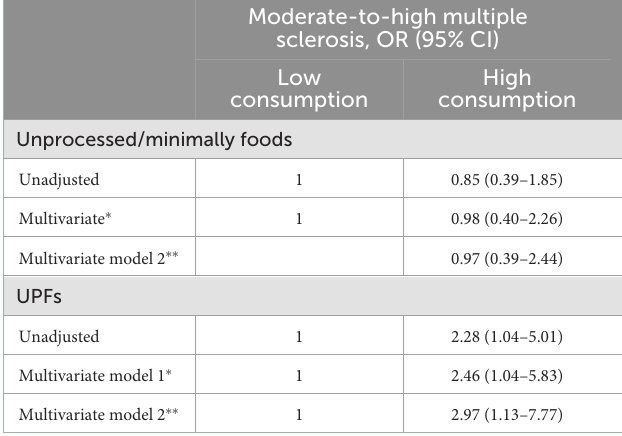
TABLE 5 Association between food intake based on level of processing and moderate-to-high multiple sclerosis (as compared to mild). Moderate-to-high multiple P - sclerosis, OR (95% CI) severity value Low